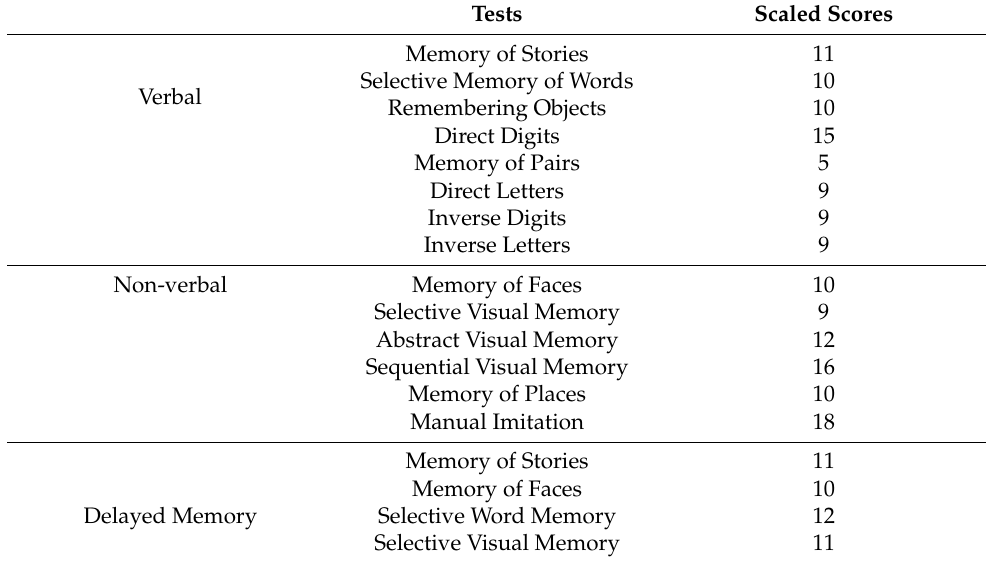
Table 1. Scaled Scores for the Test of Memory and Learning (TOMAL).